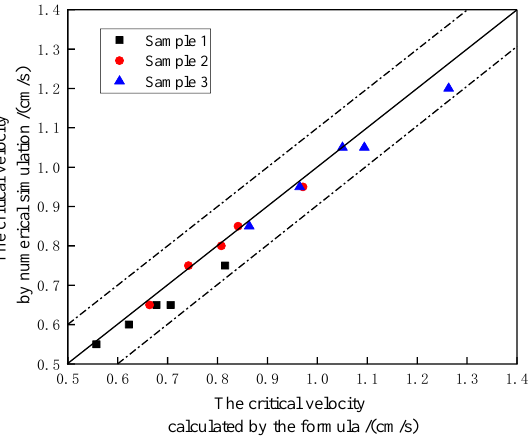
Figure 6. Comparison between formula calculation and numerical simulation.